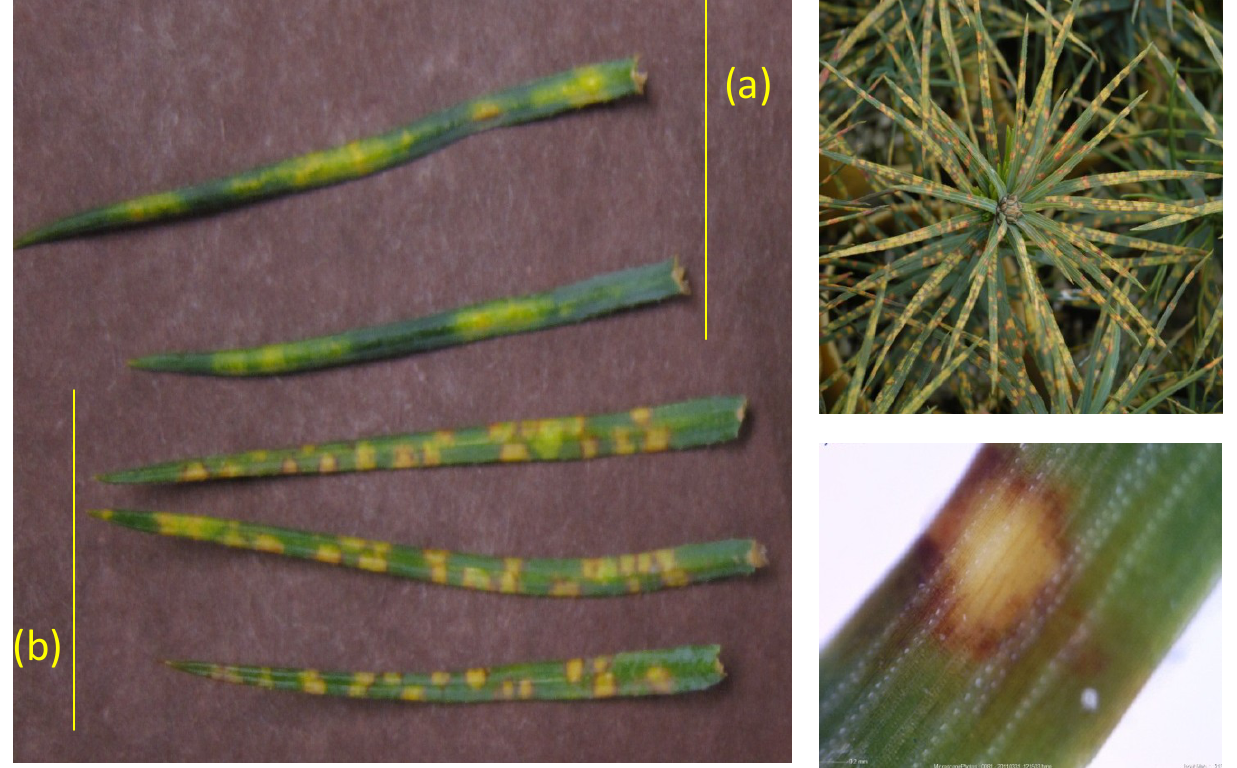
Figure 6. Western white pine showing: (a) susceptible needle infections; and (b) needle infections on a seedling with hypersensitive-like